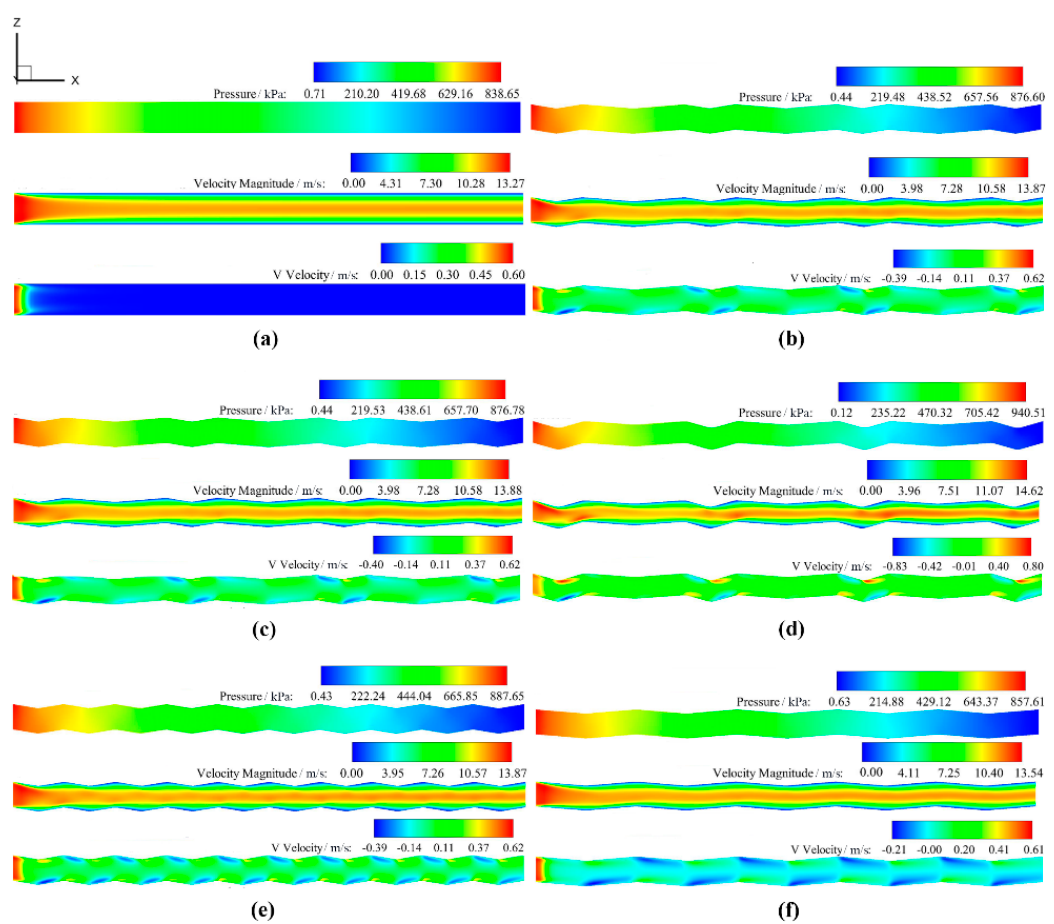
Figure 3. Single-phase flow characteristics of channels under investigation: ( a ) straight; ( b ) Design 1; ( c ) Design 2; ( d ) Design 3; ( e ) Design 4; ( f ) Design 5. V Velocity = vertical component velocity.